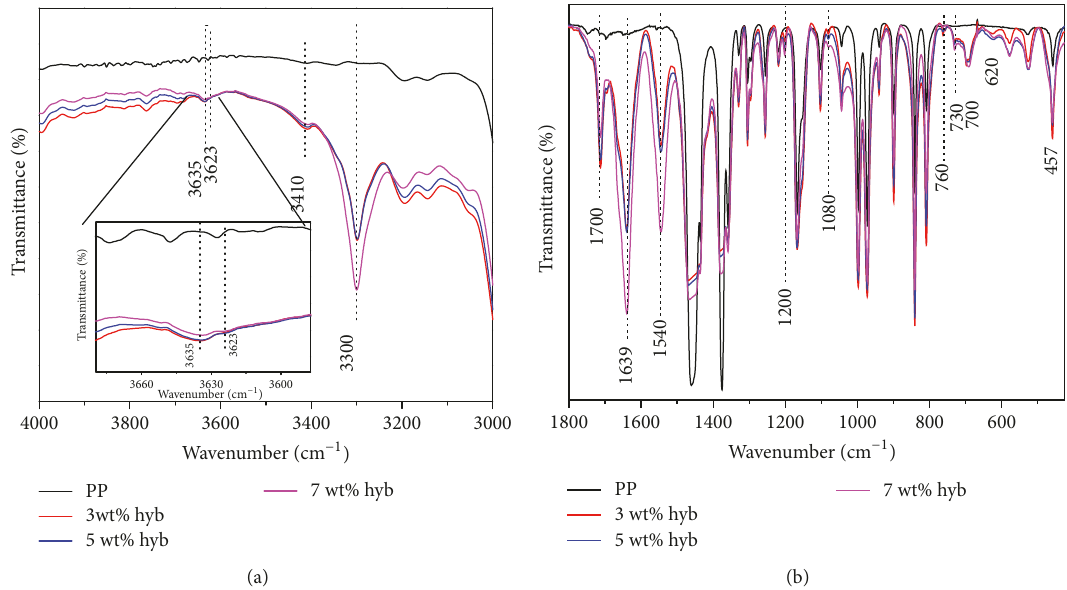
Figure 3: Fourier transform infrared spectroscopy (FTIR) spectra of (a, b) 5 wt% t-PAfs/3, 5, and 7wt% f-Na-MMT/PP hybrid